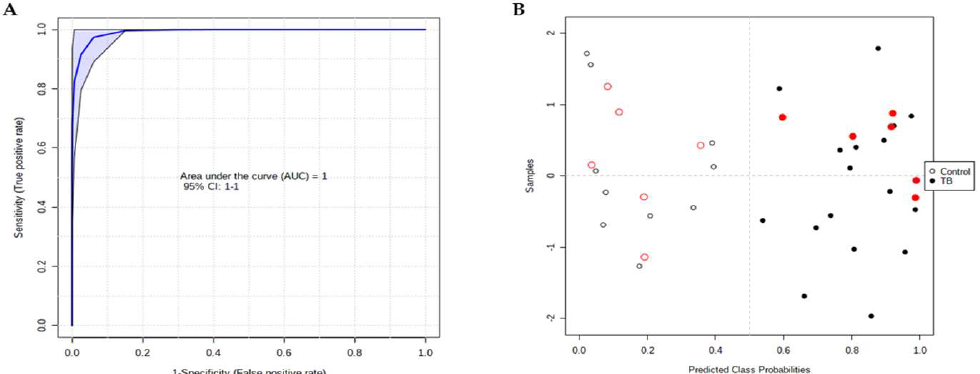
Figure 7. ROC analysis based on proteomic and metabolomic data. ( A ) The combination of four metabolites (indole-3-lactic acid, trans-3-indoleacrylic acid, hexanoylglycine, and N-acetyl-L-leucine)